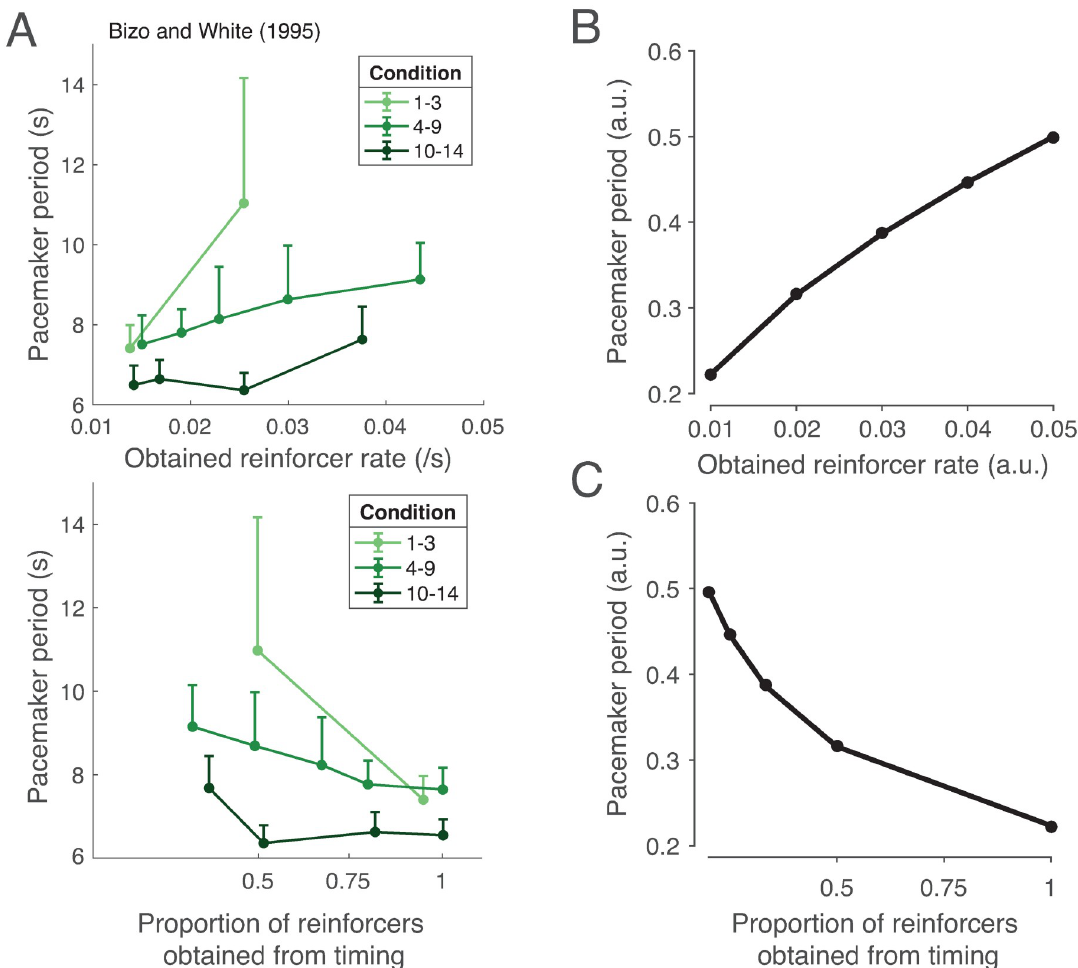
Fig 6. Rational inattention and controllability. (A) Controllability increases clock speed. Top panel: Bizo and White [134] have shown that when reinforcers are freely delivered, clock speed decreases (plotted here is the pacemaker period, or the inverse of clock speed, a parameter in their computational model which was fit to the empirical data). Bottom panel: On the other hand, when obtaining reinforcers is contingent on adequate timekeeping, clock speed increases. Light green, green, and dark green denote conditions in which free rewards were delivered during the intertrial interval, during both the intertrial interval and the trial, and during the trial only. We do not make a distinction among these conditions in our model. Figure adapted from [134]. (B, C) Our model recapitulates this effect: Under rational inattention, high average reward should only increase precision when this increase improves the ability to obtain rewards. (B) As free rewards increase and the added incentive of timing-contingent rewards decreases, clock speed will decrease. (C) On the other hand, as timing-contingent rewards increase, clock speed will increase. See Methods for simulation